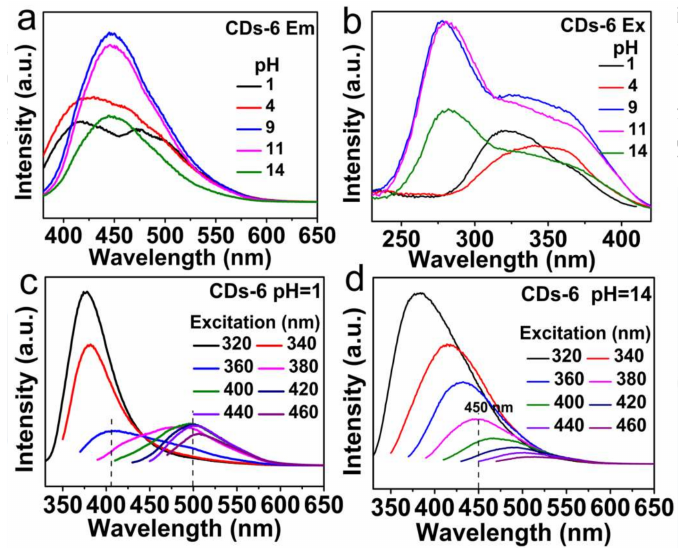
Figure 4. ( a , b ) Emission (Em) and excitation (Ex) spectra of CDs-6 by changing pH values (1, 4, 9, 11, 14) with addition of HCl and NaOH; ( c , d ) Emission spectra of CDs-6 under different excitation wavelengths in the range of 320-460 nm for pH = 1 and pH = 14,